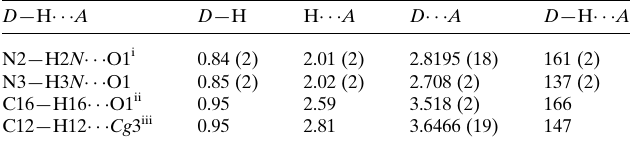
Table 1 Hydrogen-bond geometry (A˚ , (cid:2) ).